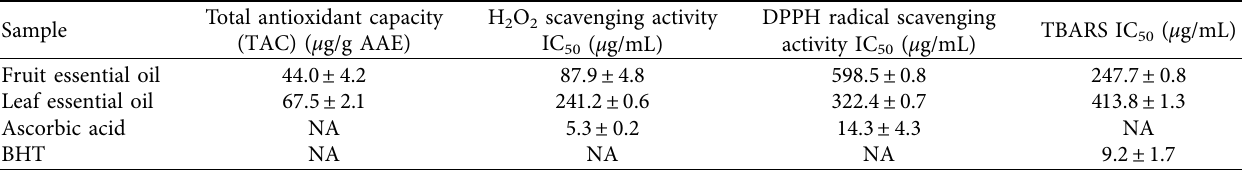
Table 4: Summary of antioxidant activities of Vitex doniana fruit and leaf essential oils.